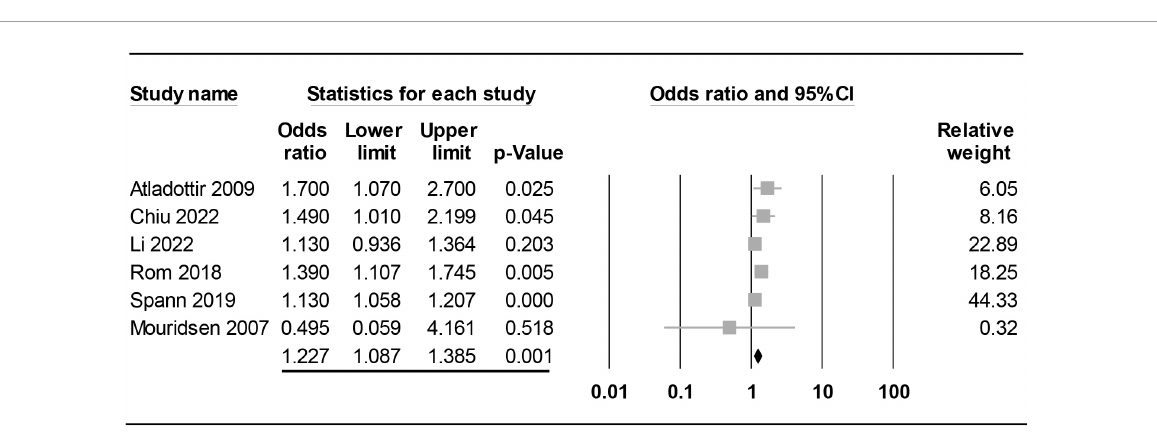
changes before childbirth on the risk of ASD in